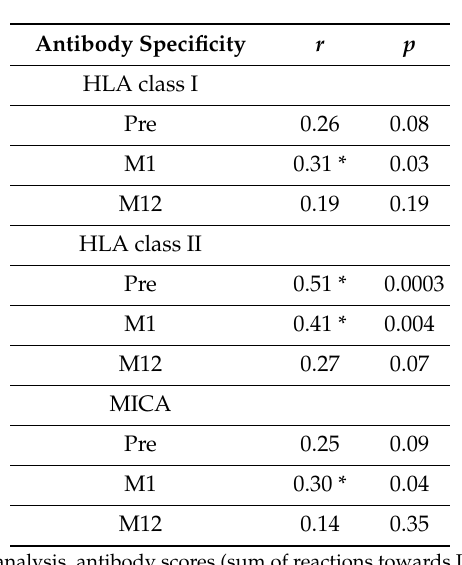
Table 6. Correlation of interval between transplantation and vaccination and HLA / MICA antibodies in 47 kidney transplant recipients pre and at month 1 (M1) and month 12 (M12) after vaccination with Prevenar.